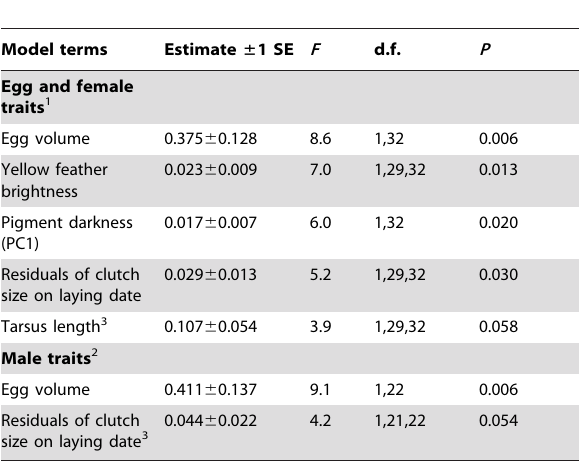
Table 2. Yolk antibody concentration of blue tit eggs in relation to egg, female, and male